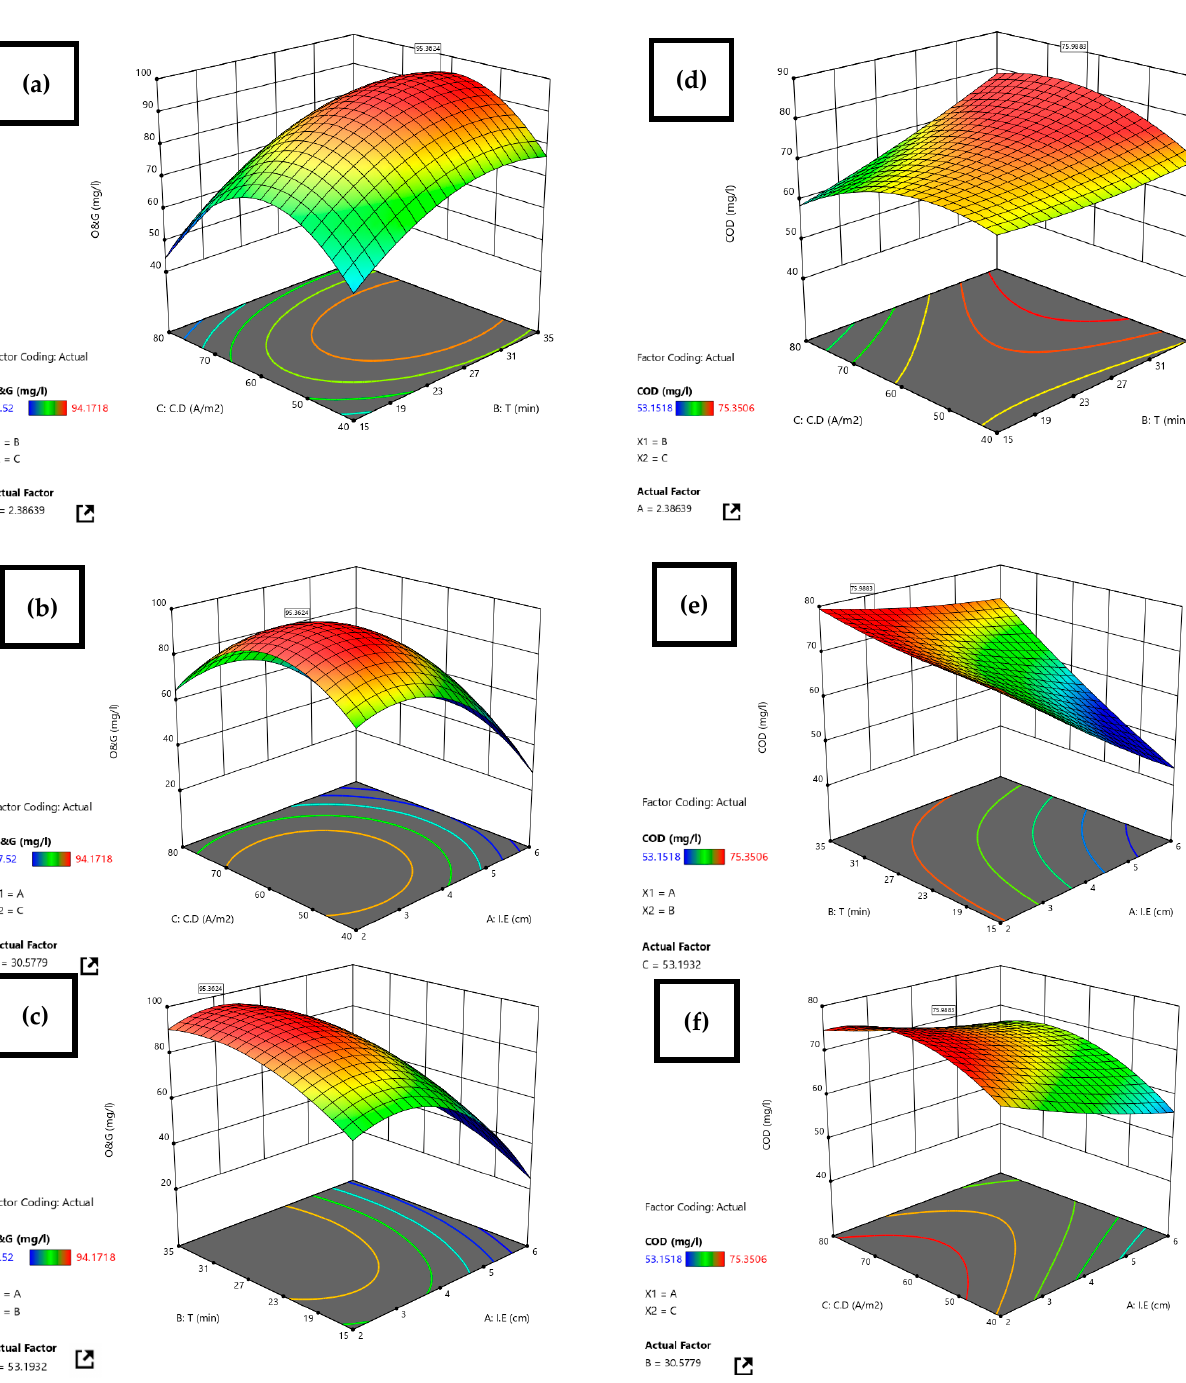
Figure 8. Three-dimensional plots for the effect of individual and interaction of the factors on the O&G and COD removal: ( a ) interaction effect of CD vs. T on O&G removal (%), ( b ) interaction effect